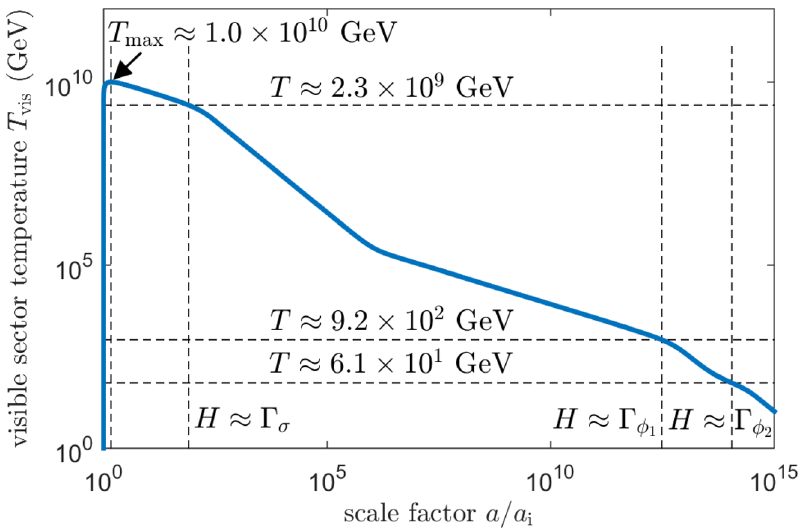
Figure 9 . Visible sector temperature as a function of scale factor in the scenario with two